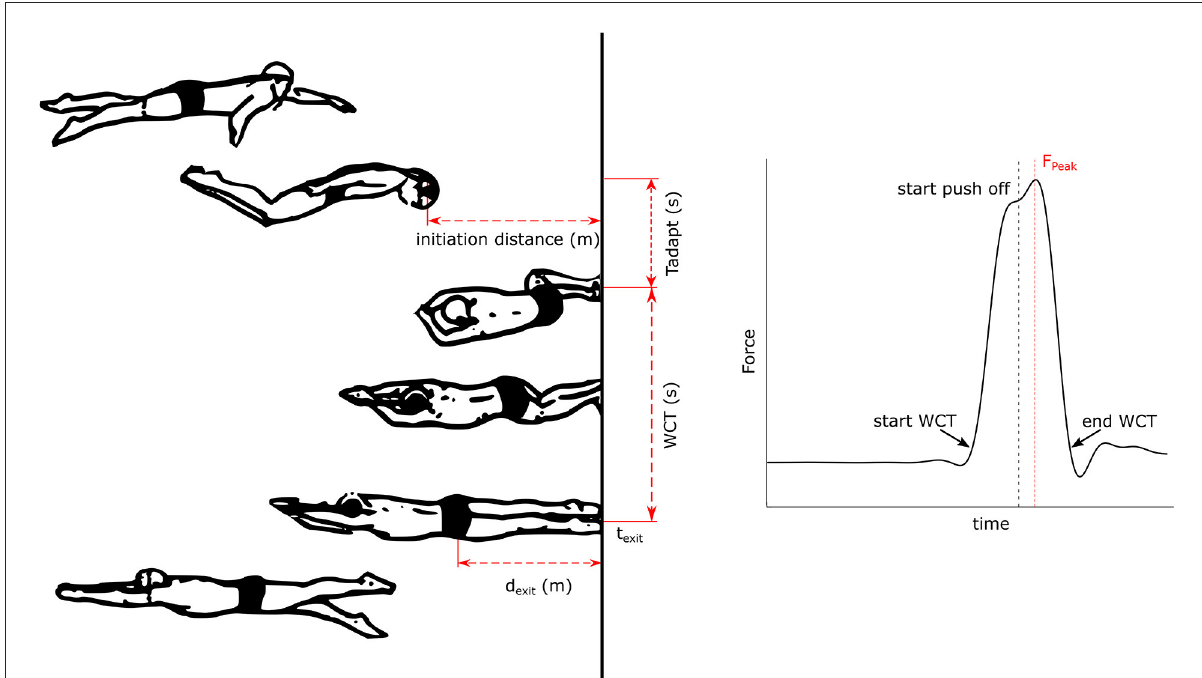
FIGURE3 Left: Tumble turn technique [adapted from Puel et al. (2012)]: Illustrating the initiation distance, d exit , WCT and T adapt . Right: Typical force profile of a reference trial indicating the start and end of the WCT with a force > 20N, F Peak and the start of the push of phase.